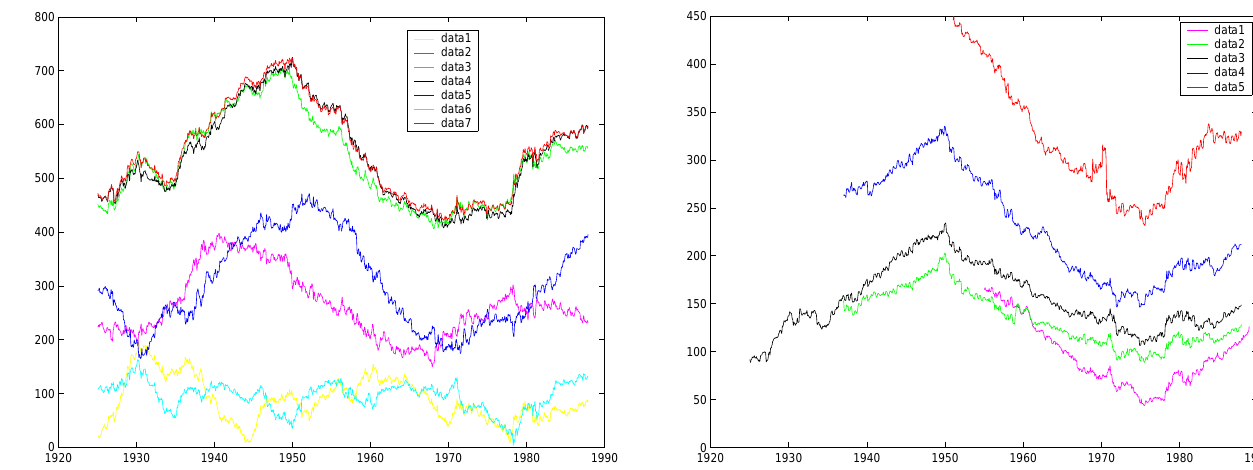
Fig. 7. Amplitude of the 6-month line, A 6 (t) , for (1) CLF (2) HAD (3) ESK (4) LER (5) SIT. Y (east) component. Vertical unit: .35 10 − 3